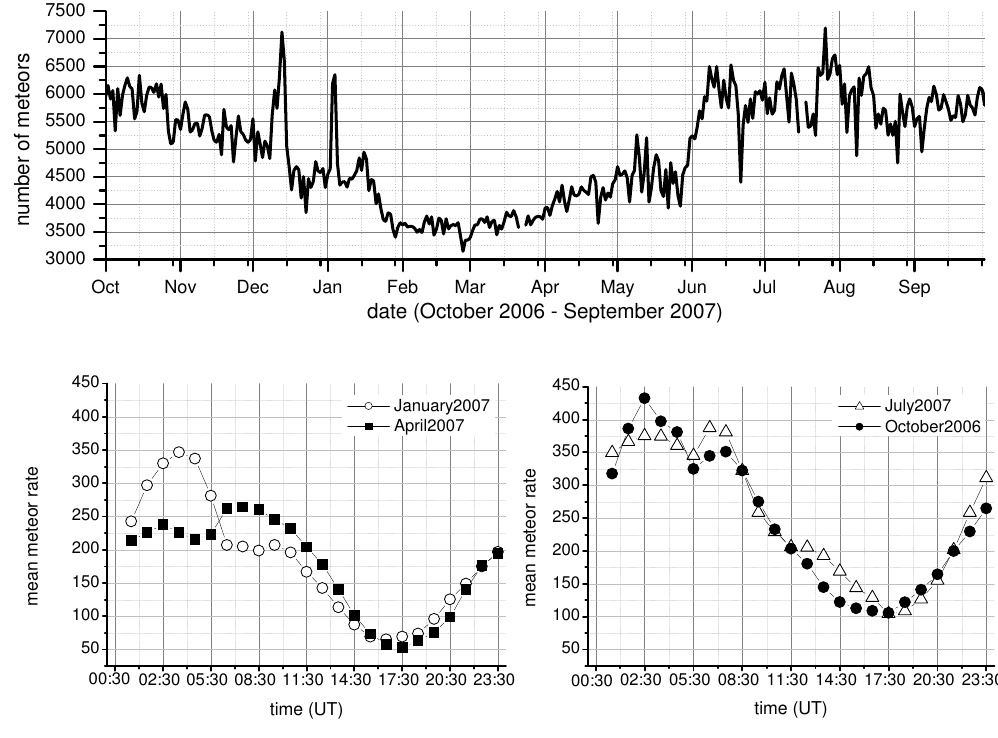
Fig. 4. Daily meteor count rates at Collm (upper panel) and monthly mean diurnal cycle of meteor count rates for four different months (lower